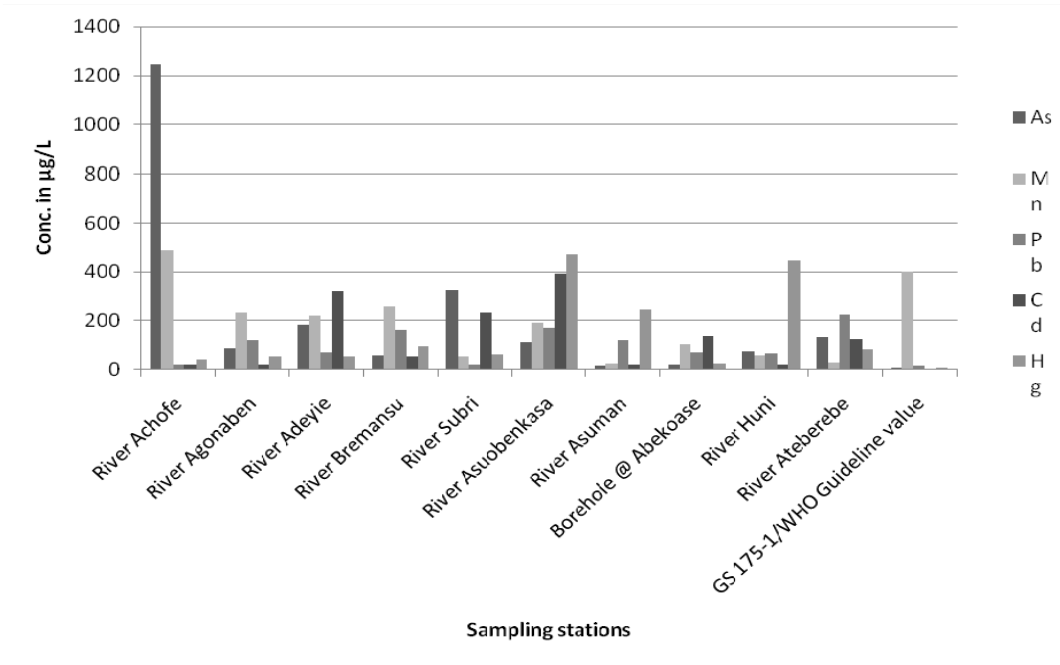
Figure 2. A graph comparing the levels of heavy metals in water samples from the study area with GS 175—1/WHO Permissible guideline values. Table 3. Descriptive statistics for physic-chemical parameter for water samples from the study area.